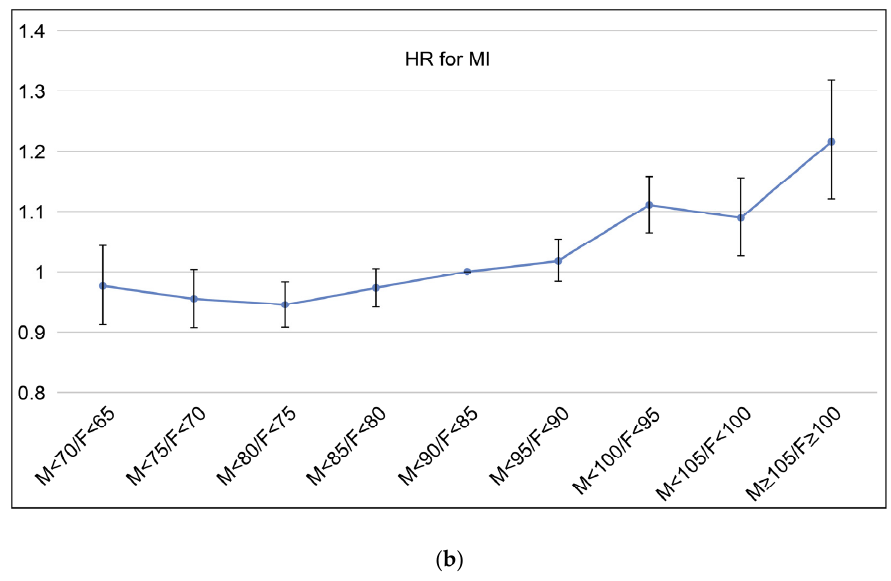
Figure 2. Graph representing hazard ratio for MI listed in Supplementary Table S2. ( a ) p for trend < 0.001, ( b ) p for trend = 0.003. HR, hazard ratio; MI, myocardial infarction. As a result, when using model 5, every analysis result showed that as BMI decreases, MI HR increases, and as BMI increases, MI HR decreases; concerning WC, lower than normal levels of the WC groups showed low MI HR or a high but statistically non-signif- icant result and the abdominal obesity group showed increased HR.